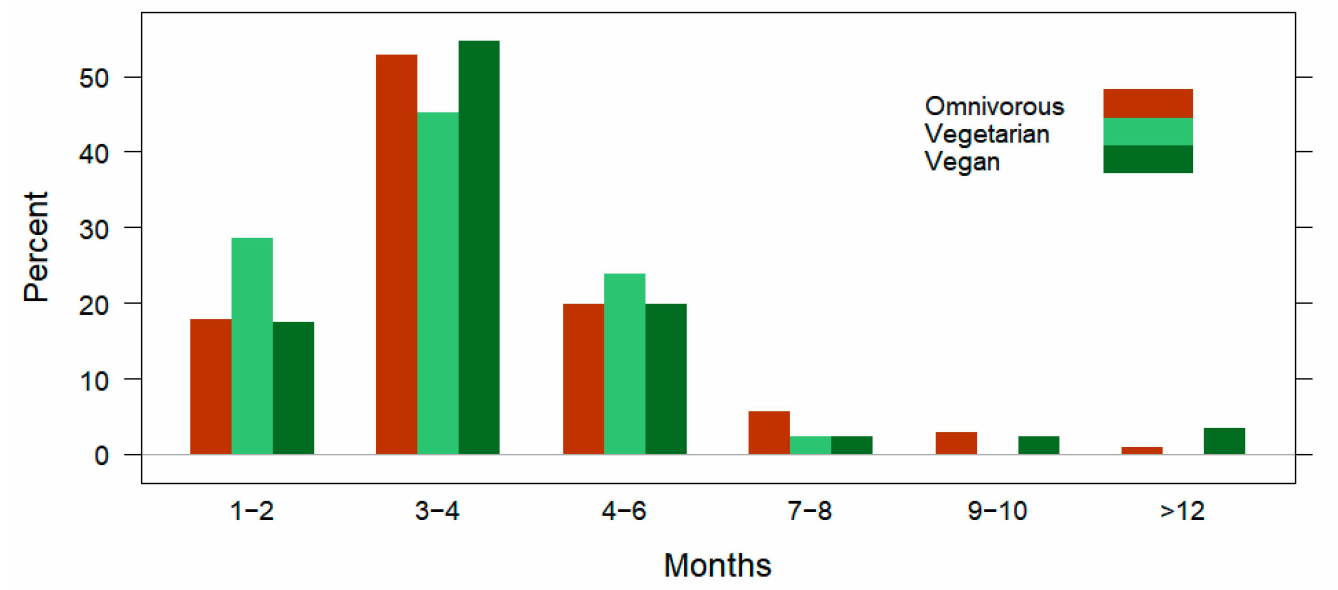
Figure 2. Prevalence of overall training durations (displayed by six clusters) of omnivores, vegetari- ans, and vegans. Data are presented as the percentage.